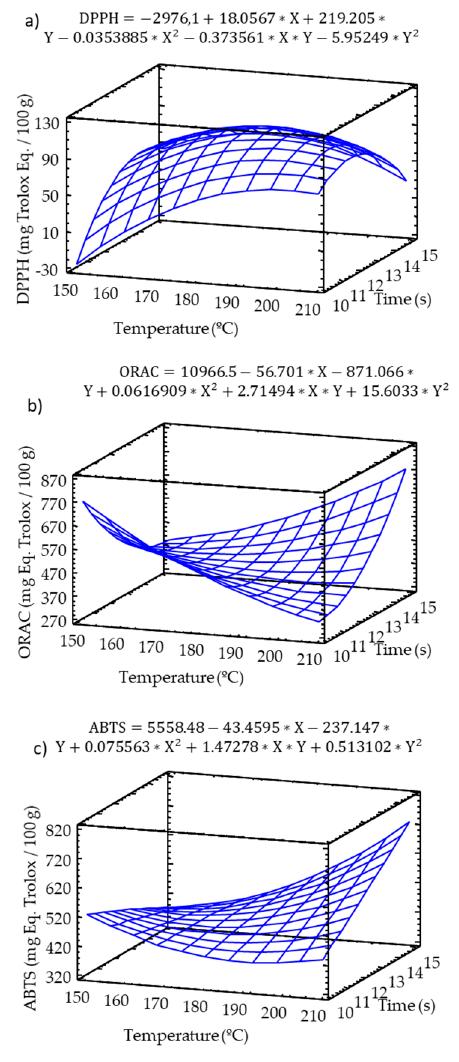
Figure 4. Response surface model of the effect of temperature and time on ( a ) DPPH, ( b ) ORAC, ( c ) ABTS.